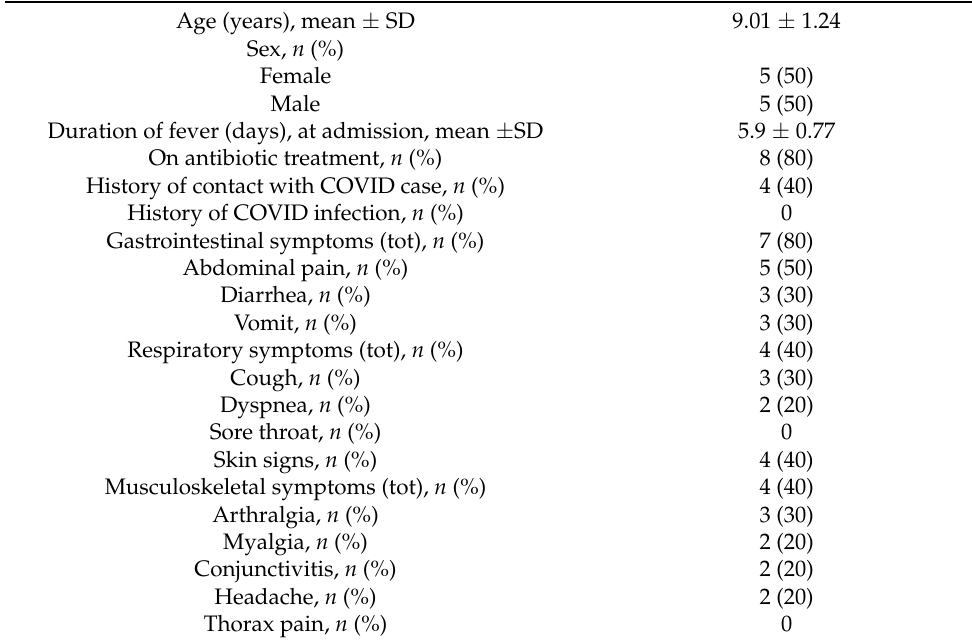
Table 1. Clinical characteristics at